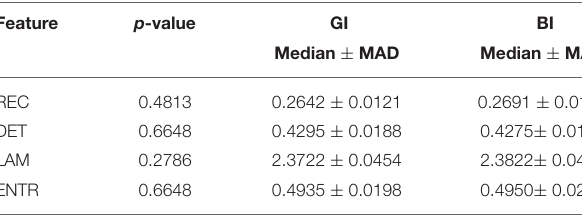
TABLE 4 | Statistical comparison between BI and GI considering only the easy task. Feature